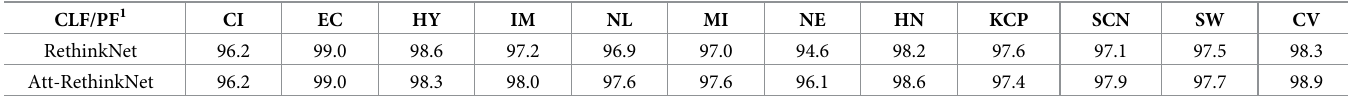
Table 5. ACC lab of all pathological findings for RethinkNet and Att-RethinkNet in liver data. CLF/PF 1